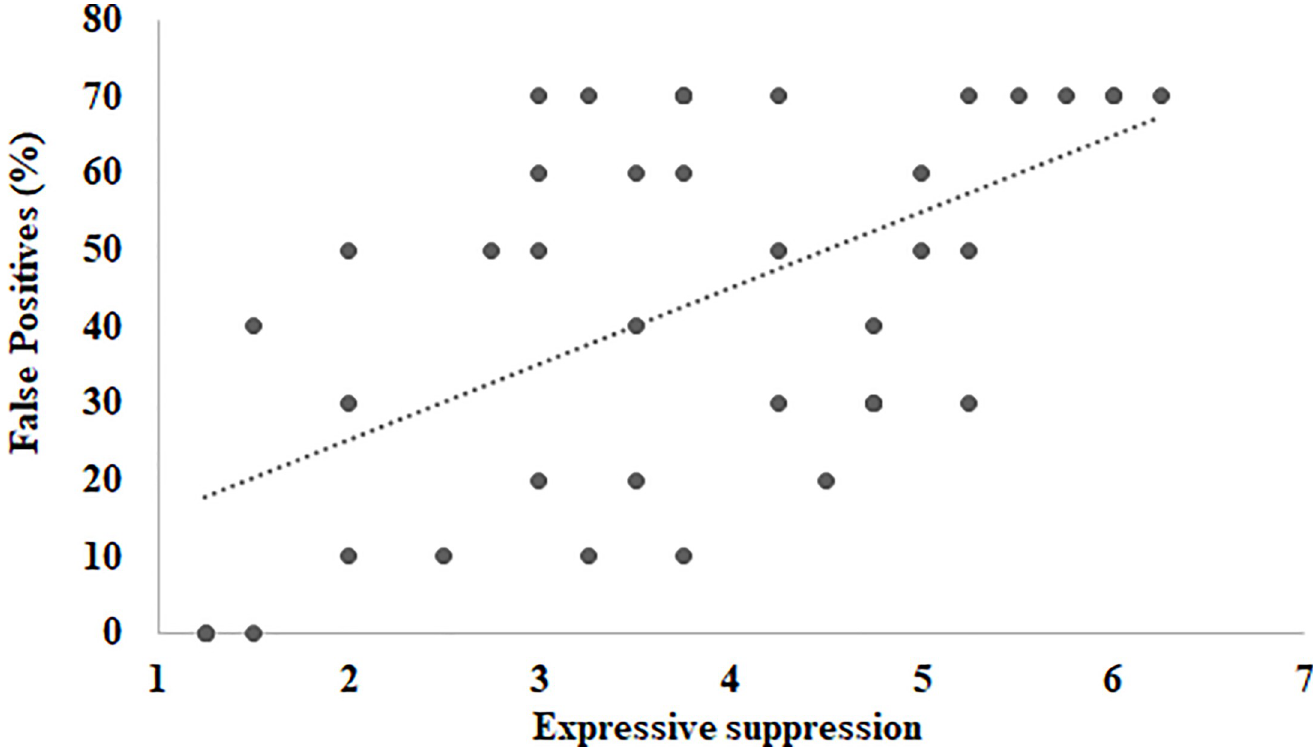
Fig 2. Scatter plots for the relationship between expressive suppression and false positives in face immediate memory in Experiment 1. r (40) = .57, p < 0.001, with 95% confidence internals of .32 to .74. https://doi.org/10.1371/journal.pone.0243209.g002 Table 2 shows Pearson Correlation coefficients between face immediate memory and ERQ strategies. Cognitive reappraisal did not correlate with any measures of face memory ( mean r = .06). However, expressive suppression evidenced a moderate to strong negative correlation with the overall accuracy of face immediate memory ( r = -.52, p < 0.001). Specifically, higher levels of expressive suppression were associated with a lower level of overall face-memory accuracy and higher rates of misidentifications and false positives. Fig 2 shows scatter plots for the relationship between expressive suppression and false positives. No associations were found for hits and misses.